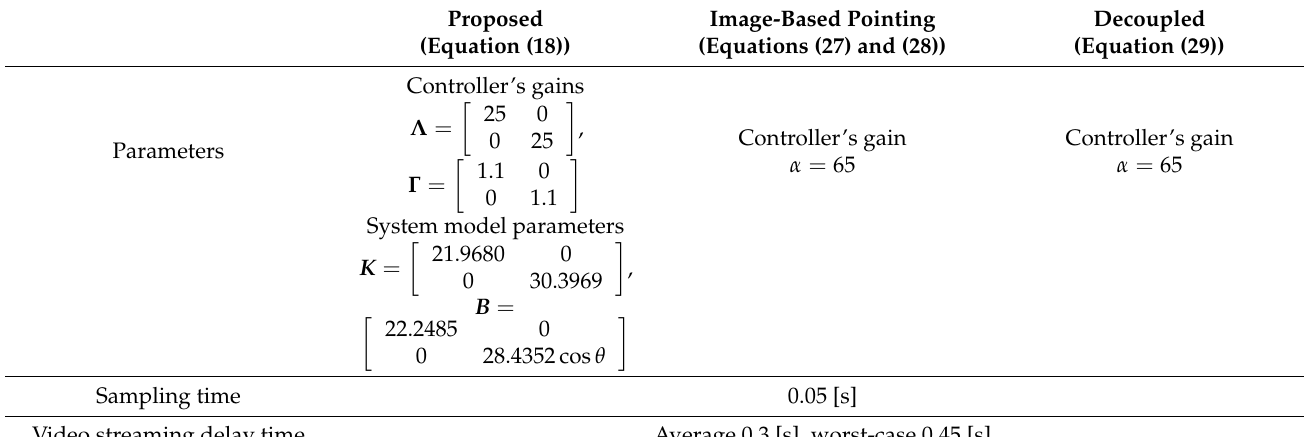
Table 1. Control system